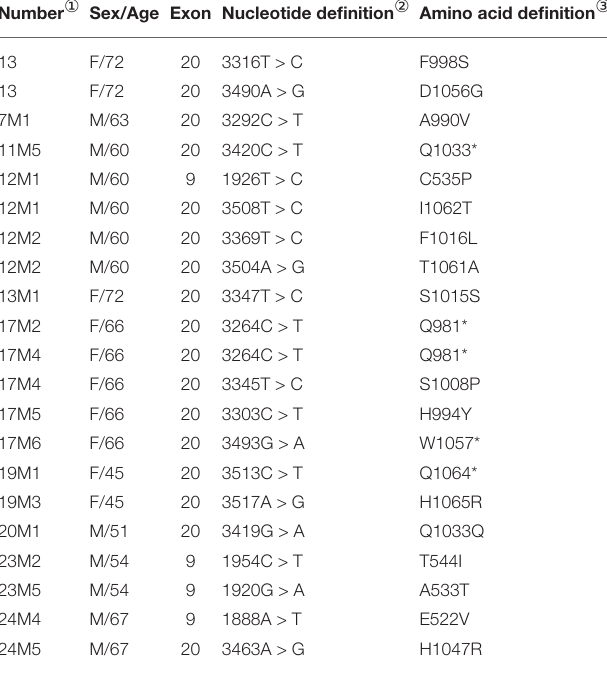
TABLE 3 | Detection of PIK3CA gene mutation of two